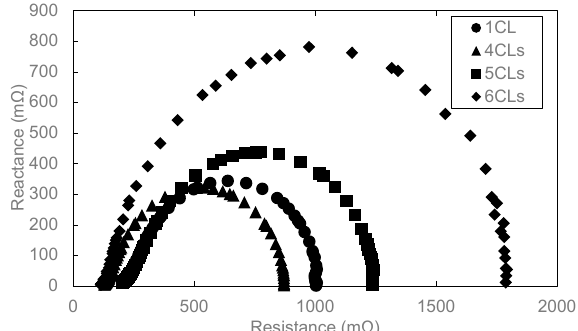
Figure 5. Influence of the number of layers on Cole–Cole plots under 0.1 A/cm 2 of current density.